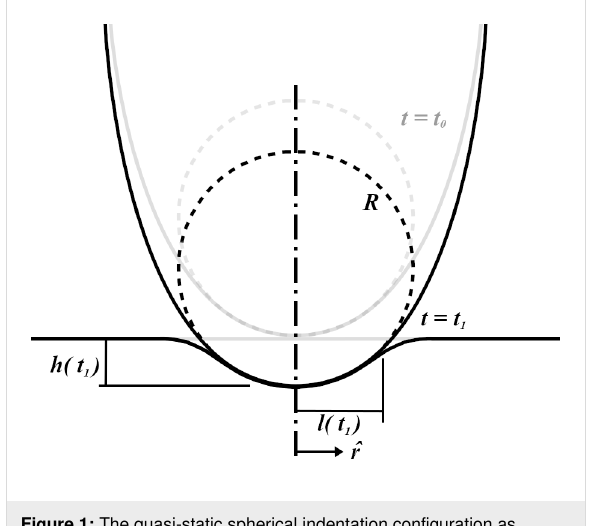
Figure 1: The quasi-static spherical indentation configuration as outlined by Lee and Radok in [18].